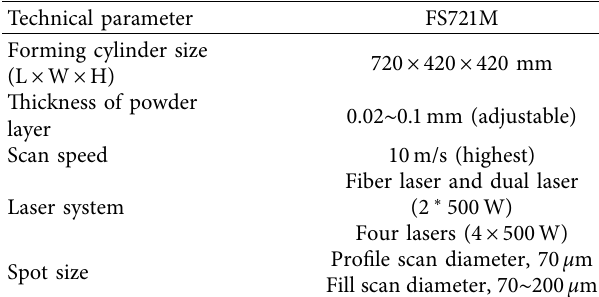
Table 2: Printing equipment performance